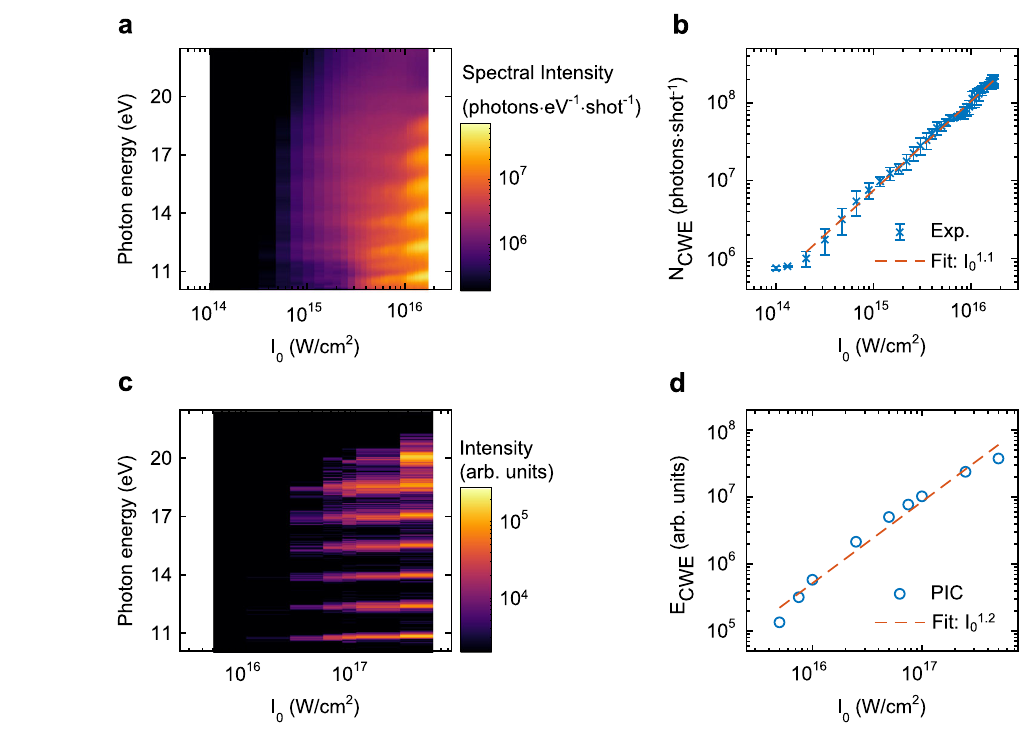
Fig. 4 | Intensity scaling of CWE from a liquid plasma mirror. a , b Angle- integrated CWE spectra ( a ) and the sum of the observed spectral intensity of the CWE spectra ( b ) between 6 : 5 ω 0 and 14 : 5 ω 0 obtained in experiments for different peak intensities of the driving laser. The data points are the mean values of fi ve independent measurements. The error bars show the standard deviation. c , d Angle-integrated CWE spectra ( c ) and the sum of the intensity of the CWE